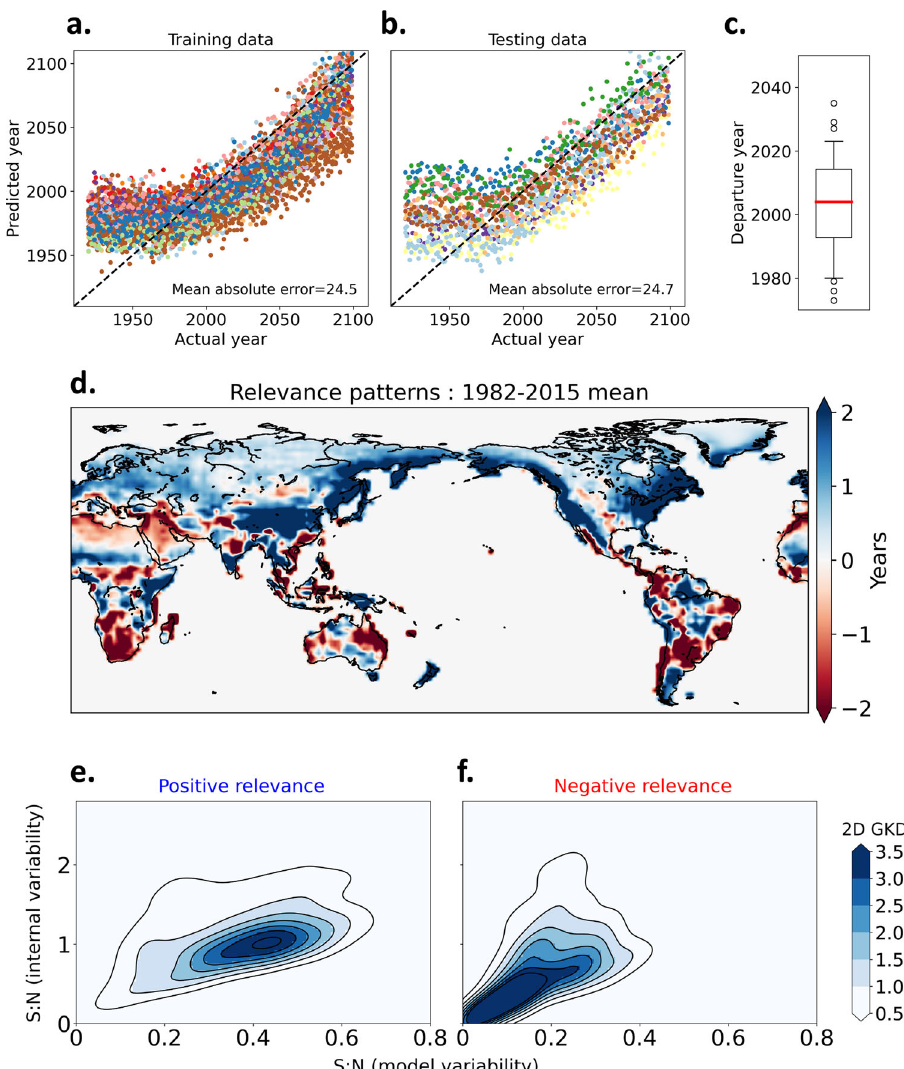
Fig. 1 Fingerprint of external forcing in simulated Rx1day learned by the neural network. a , b Actual year vs predicted year for training data derived from CMIP5 and CMIP6 global climate models (GCMs) ( a ) and testing data derived from CMIP5 and CMIP6 GCMs ( b ) for a single neural network. Each GCM is represented by a different color. c The year of departure from the base period, 1920 – 1949. Whiskers represent the 5th – 95th percentiles, while blank circles represent outliers. d Multimodel, ensemble-mean, layer-wise-relevance-propagation-based relevance maps for annual maximum daily precipitation (Rx1day) input for the period 1982 – 2015 from all models. Relevance is the contribution of each grid value to the neural network ’ s decision (see “ Methods ” ). e , f Signal-to-noise ratio (S:N): two-dimensional Gaussian kernel density (2D GKD) estimation plots for grid cells with a positive relevance ( e ) and negative relevance ( f ) in panel ( d ). Signal is de fi ned as the multimodel mean change in Rx1day between the base period 1920 – 1949 and 2070 – 2099. Noise is de fi ned in two ways: the fi rst stems from internal variability and is calculated as the multimodel ensemble mean of the standard deviation in Rx1day during the base period. The second pertains to intermodel variability and is calculated as the intermodel standard deviation of the signal from each (Fig. 1e, f). The S:N is lower for both internal variability and